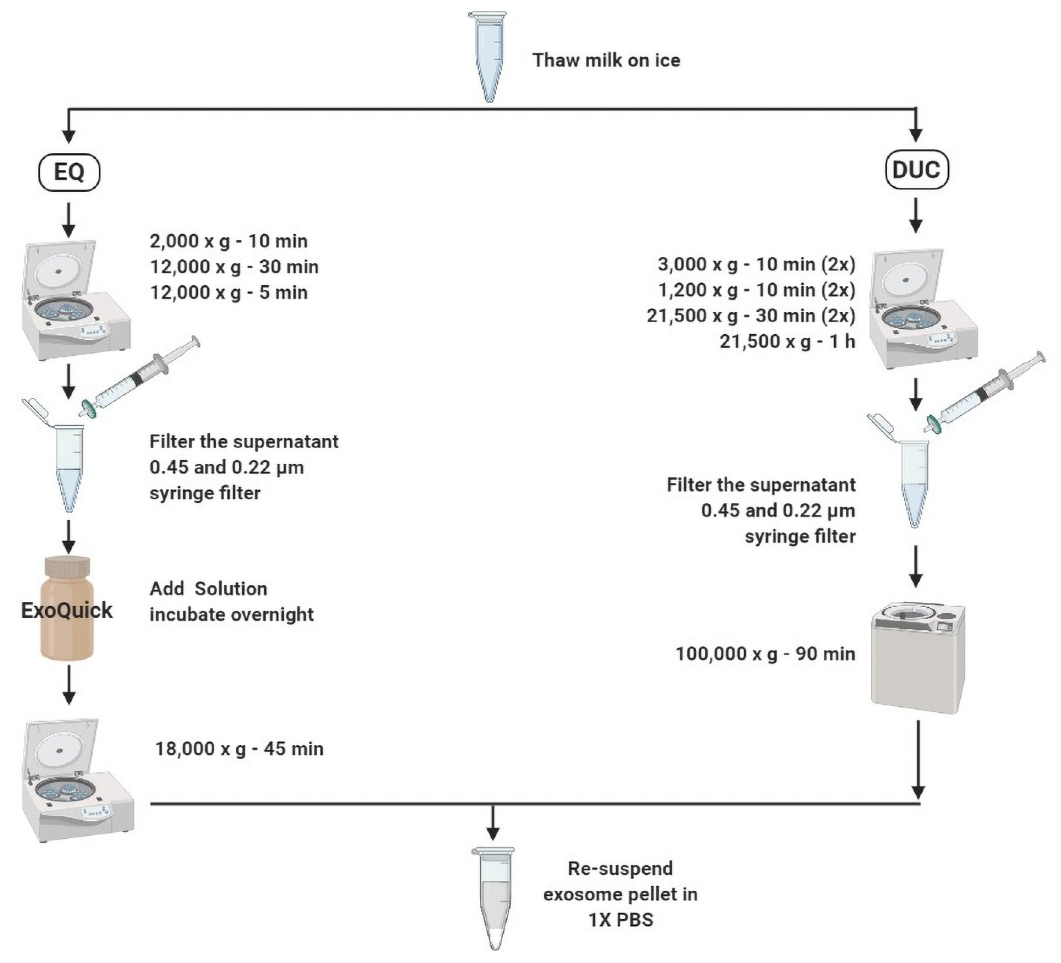
Fig 2. Bovine and human milk-derived exosome isolation via ExoQuick (EQ) precipitation and differential ultracentrifugation (DUC)